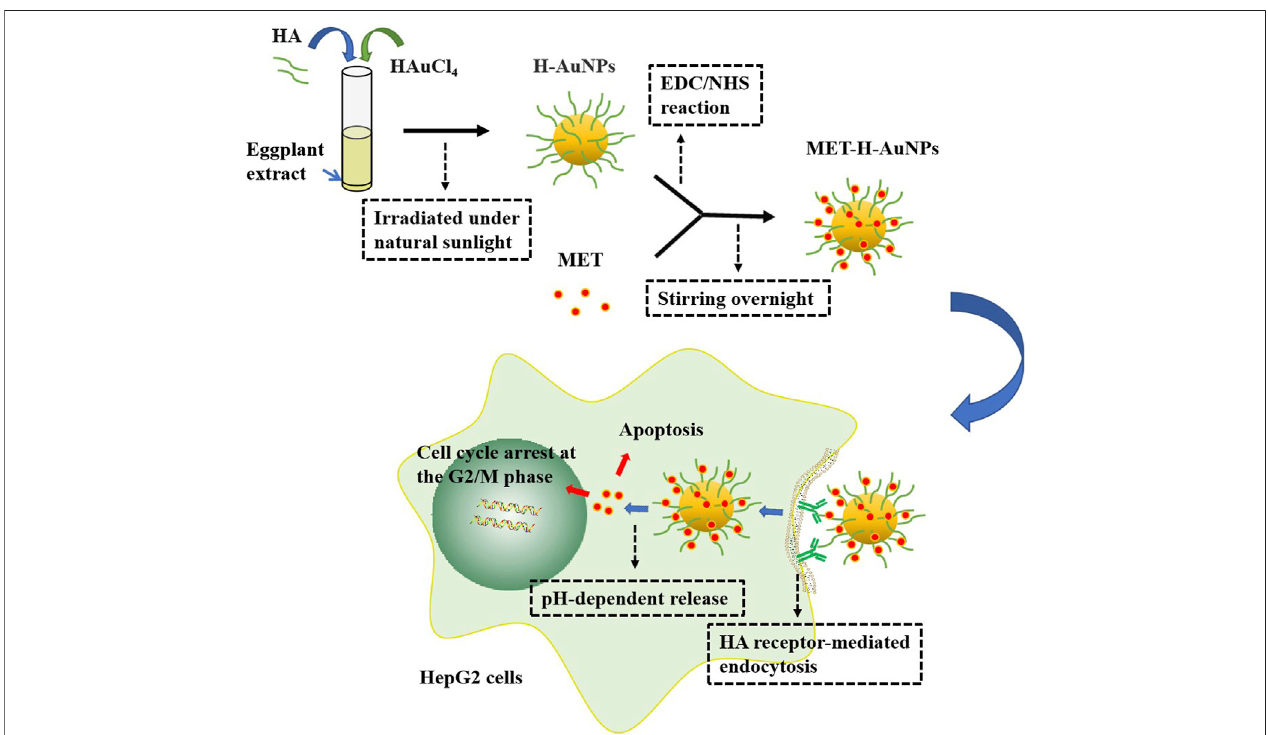
FIGURE 4 | Synthesis of MET-H-AuNPs and targeted antitumor pathway. H-AuNPs are synthesized with the mixture of HAuCl4, HA, and eggplant extract irradiatedundernaturalsunlight.Afterbeingmodi fi edbyEDC/NHSreaction,H-AuNPsconnectMETwiththeamidebondformedbystirringovernightbetweencarboxyl groups of HA and amine group of MET to generate MET-H-AuNPs. MET-H-AuNPs are taken up into HepG2 cells through HA receptor – mediated endocytosis and release MET in a pH-dependent way which could induce cell cycle arrest signi fi cantly at the G2/M phase and apoptosis.